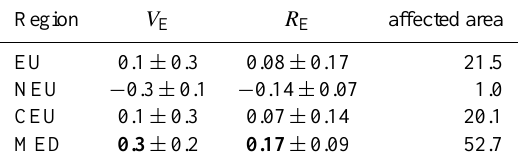
Table 2. Ecosystem vulnerability V E and risk R E (mean value ± standard deviation) and percentage of affected area (%) in Europe and in the SREX regions (Table 1) of yearly carbon loss (NBP < 0) to the env variable S ( − ) for significant cells. Bold numbers denote high positive values (mean value > standard